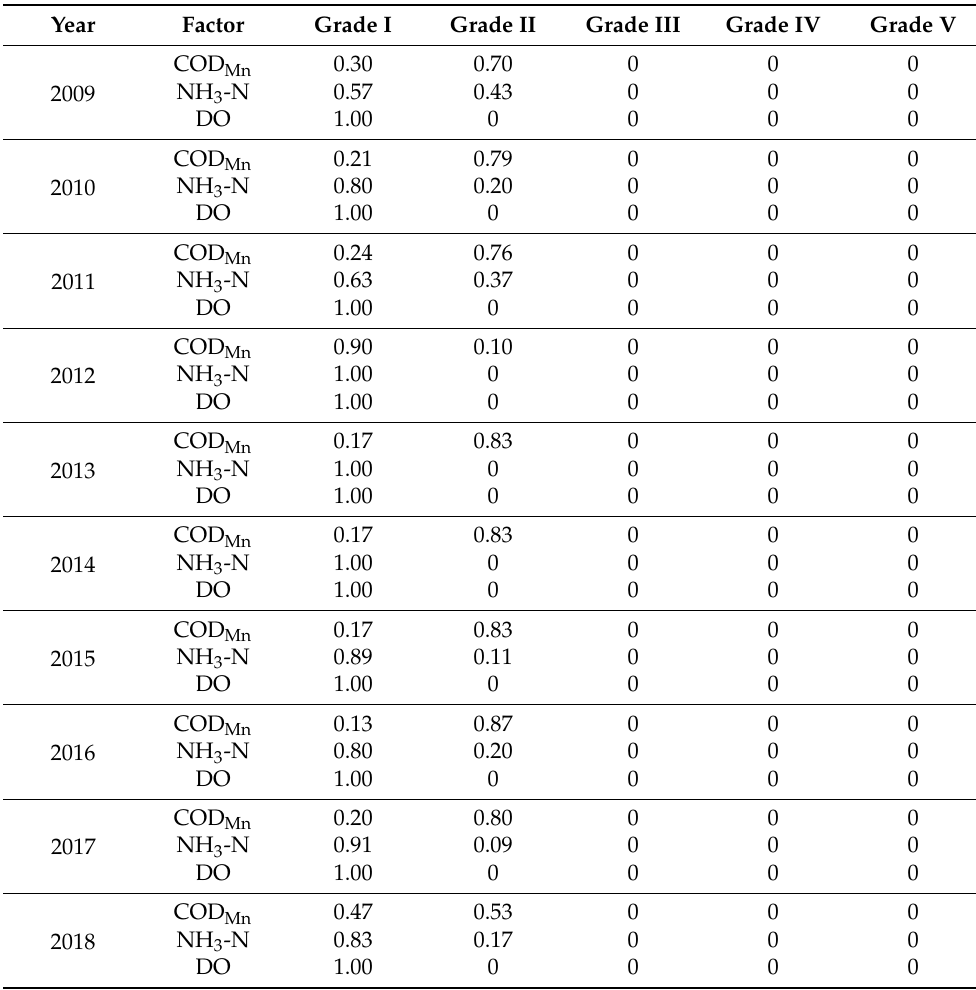
Table A4. Fuzzy matrix of Shazhu Station in Wuxi,